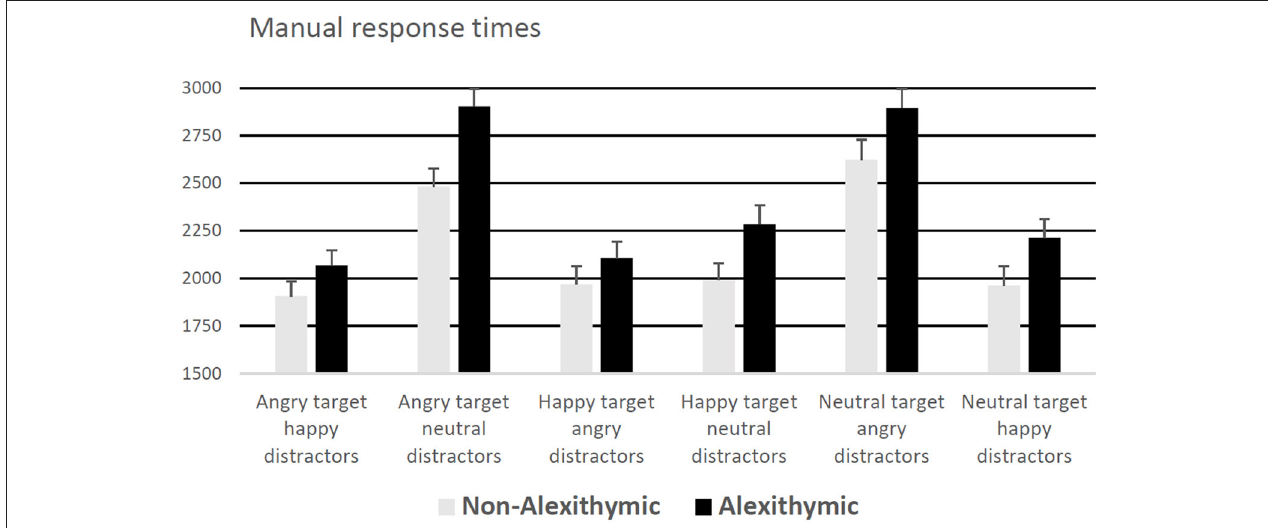
FIGURE 1 | Manual response times (for correct responses) in ms as a function of alexithymia and emotional quality of target and distractor face (error bars represent standard error).